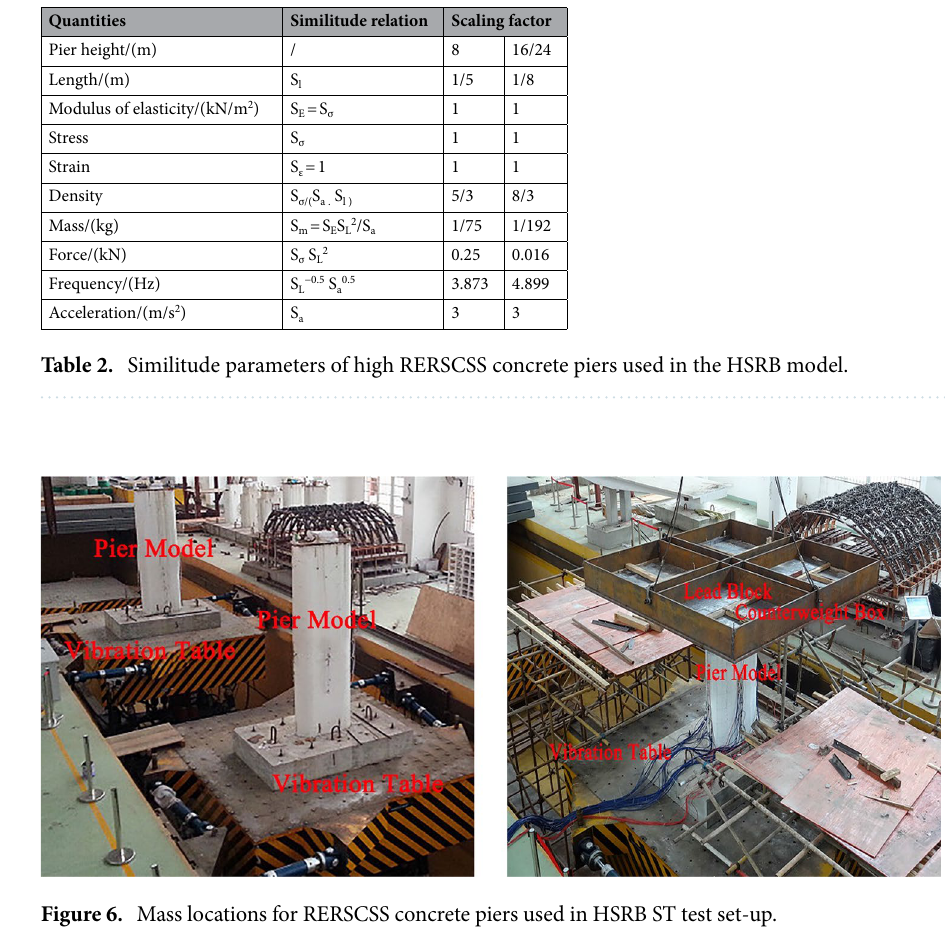
Figure 6. Mass locations for RERSCSS concrete piers used in HSRB ST test set-up.